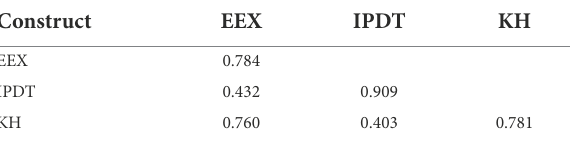
TABLE 2 Discriminant validity (Fornell-Larker-1981 criteria; mediation).